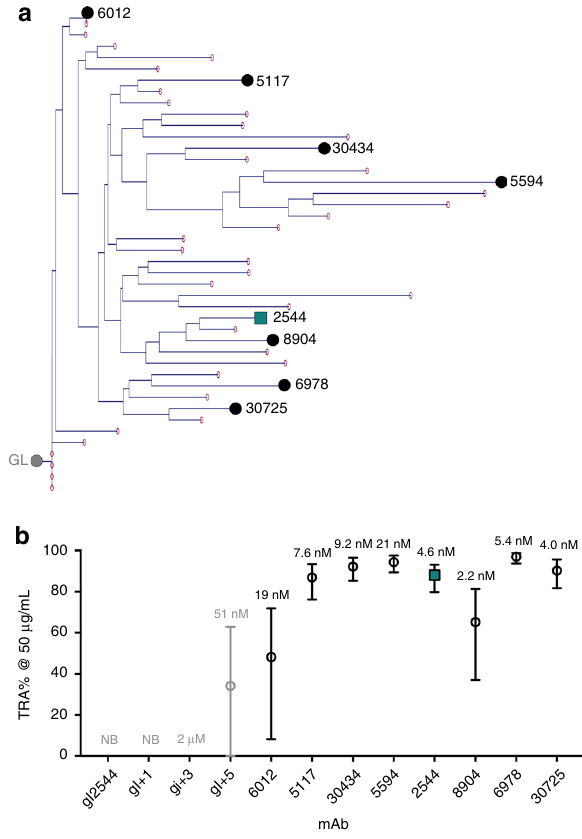
Fig. 6 The 2544 lineage shows potent SMFA activity. a Phylogenetic tree of the 2544 lineage. The gray, leftmost circle refers to the position of the inferred germline precursor. Red circles indicate sequenced members of the lineage; the length of blue lines represents the evolutionary distance from germline. Antibodies chosen for further characterization are denoted by a black circle and labeled. 2544 is displayed as a teal square. b Transmission- reducing activity (in percentage) for gl2544 (gray), germline mutants (gray), and 2544-lineage member mAbs (black) in SMFA at 50 µ g/mL. K D for each Fab binding to recombinant Pfs25 is denoted above its bar of SMFA activity. NB, no binding constant measured. Data are the result of two separate feeds, and the best-estimate (circles) and the 95% CI (error bars) of %TRA values are